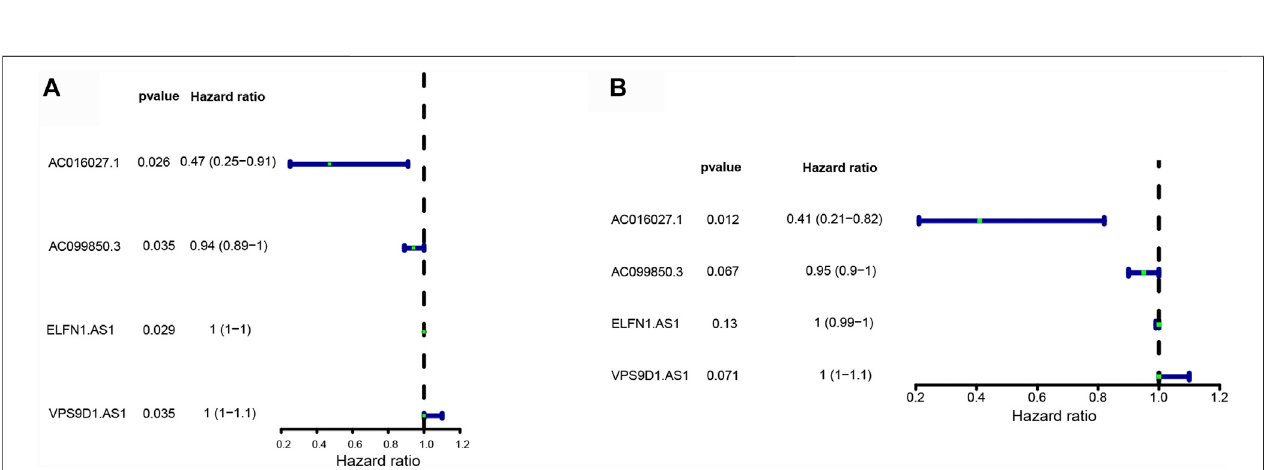
Frontiers in Genetics |